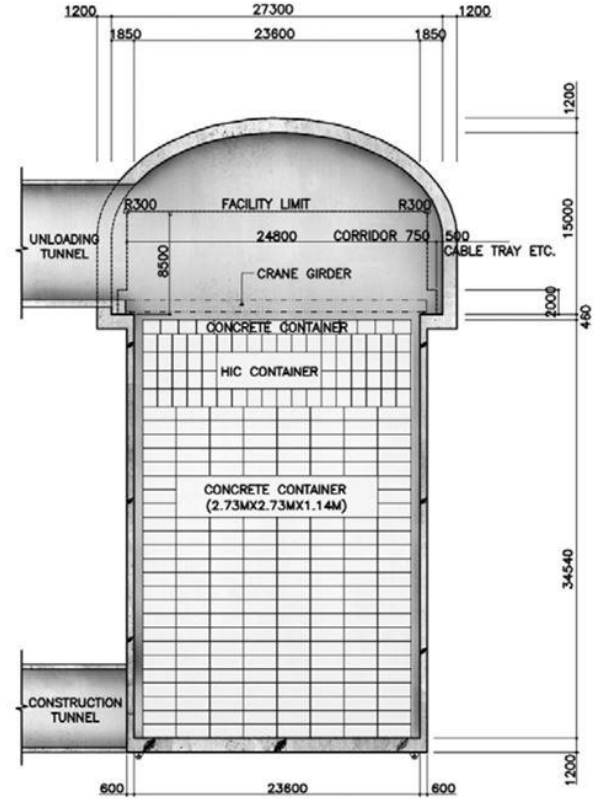
Figure 4. Drawing and dimensions of underground silo (unit: mm).